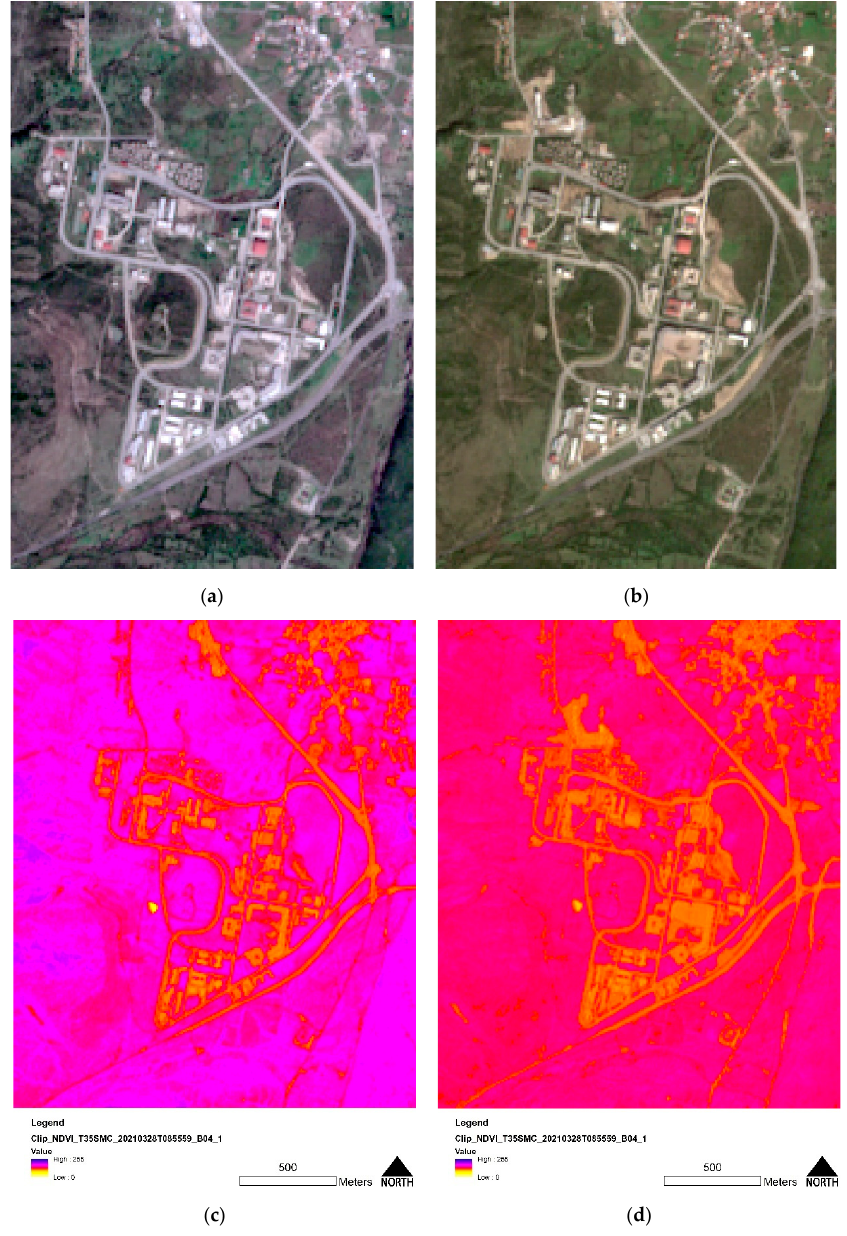
Figure 2. Comparison of RGB ( a ) 2021 and ( b ) 2022 and NDVI ( c ) 2021 and ( d ) 2022. In Figures 3 and 4 it can be seen that the violet (numbered) areas were extracted from Hotspot analysis while recording a high statistical significance.